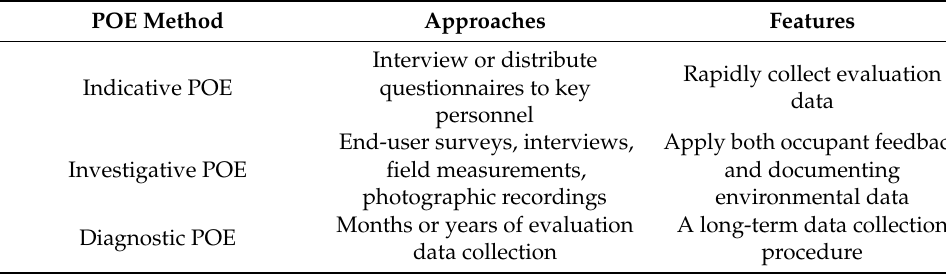
Table 1. Post-occupancy evaluation